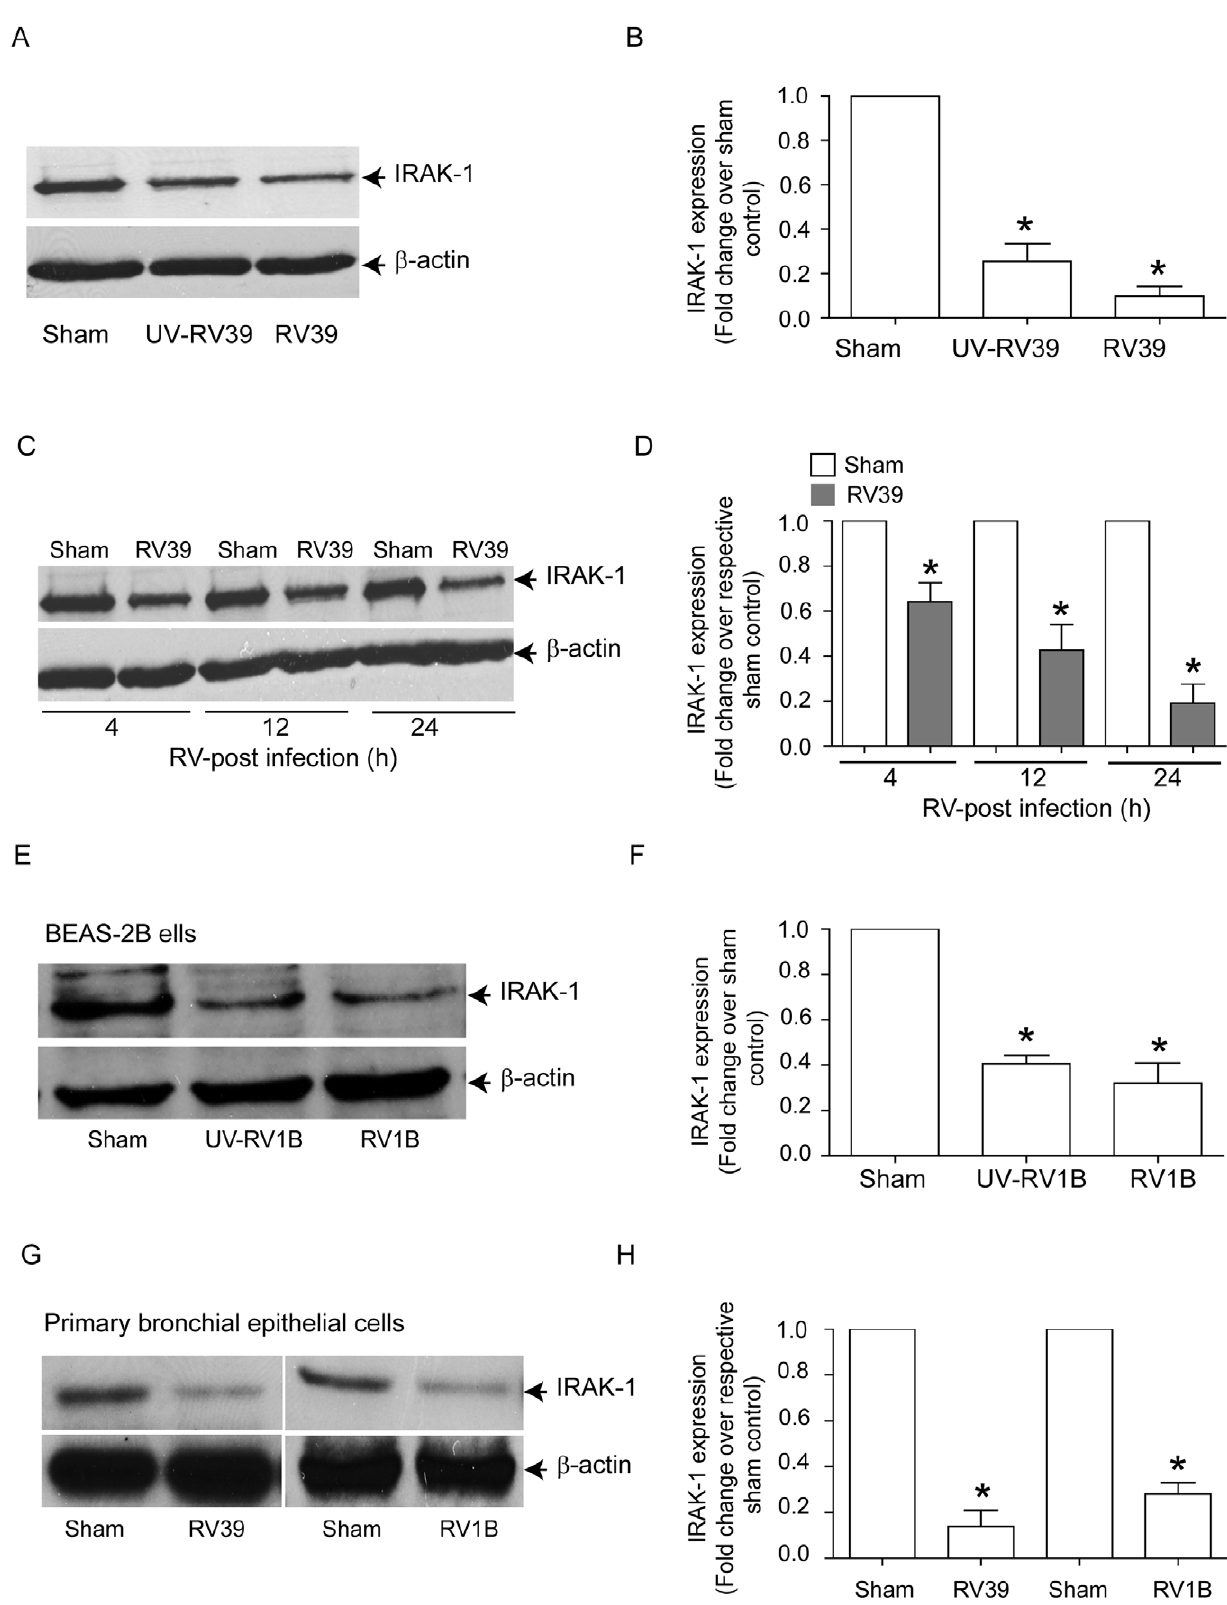
Figure 6. RV infection decreases IRAK-1 protein levels in both BEAS-2B and primary airway epithelial cells. (A and B) BEAS-2B cells were infected with sham, RV39, or UV-RV39, incubated for 24 h and the cells were lysed in RIPA buffer. The cell lysates containing equal amounts of protein was subjected to Western blot analysis with IRAK-1 antibody. (C and D) BEAS-2B cells were infected with sham or RV39 and cells were lysed at 4, 12